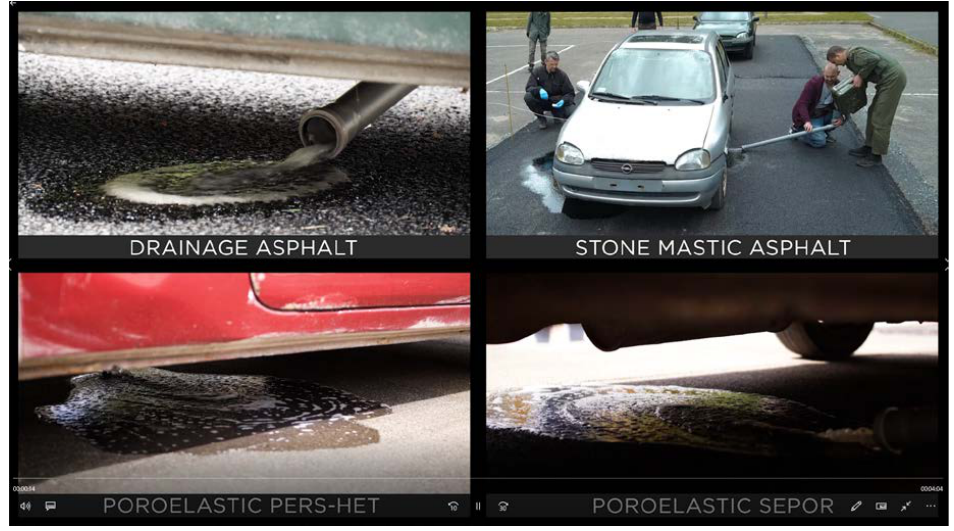
Figure 37. Fuel spills under test cars.